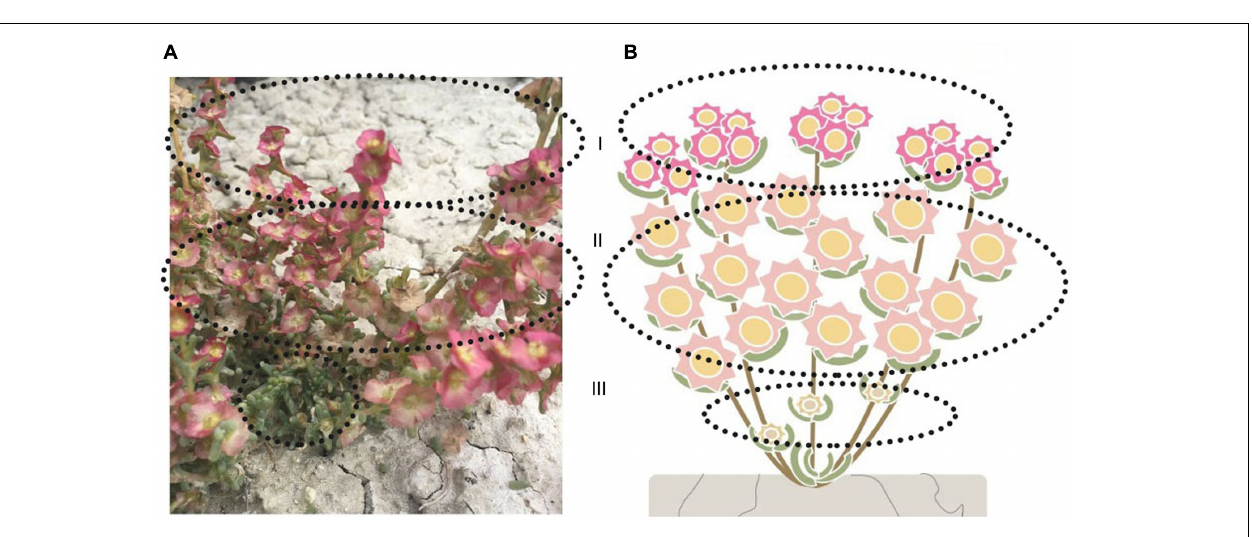
FIGURE 5 | Schematic diagram of seed (fruit) setting pattern of heteromorphic seeds (fruits) of S. ferganica. (A) Picture of plant in fruit-bearing stage in its natural habitat. (B) Schematic diagram of fruit-bearing pattern. (I) The top part of the plant (branches), mainly including medium-sized seeds. (II) The middle part of the plant (branches), mainly including large-sized seeds. (III) The base part of the plant (branches), mainly including small-sized seeds. The dashed-line circle indicates different part of the